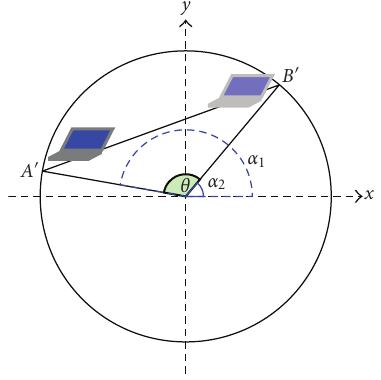
Figure 1: Scenario of datadownload on go.